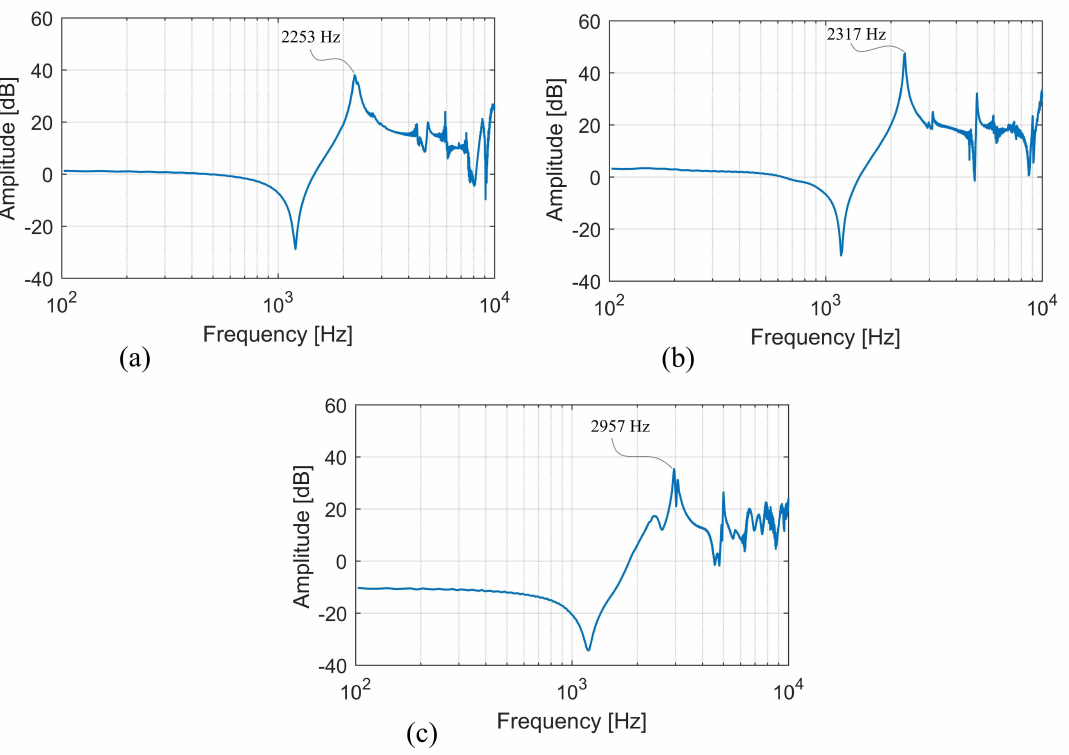
Figure 10. Frequency response of the dynamometer: ( a ) x-direction; ( b ) y-direction; ( c )